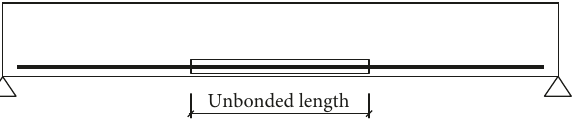
Unbonded length Figure 5: Partial unbonded reinforced concrete beam.